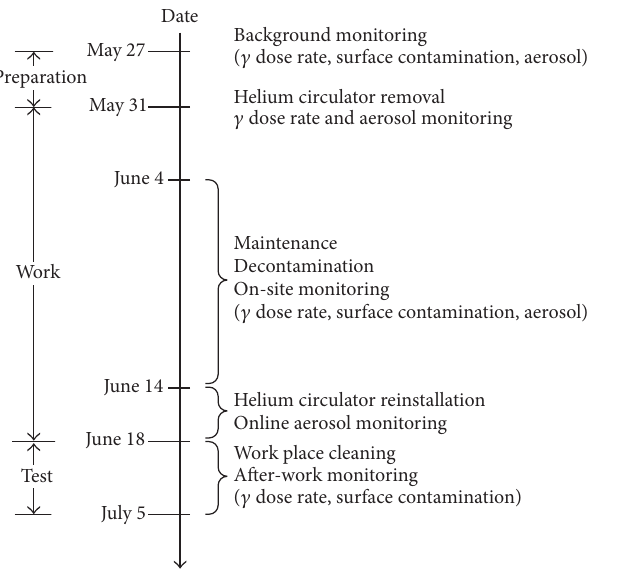
Figure 2: Work flow and radioactivity measurement of the helium circulator maintenance for